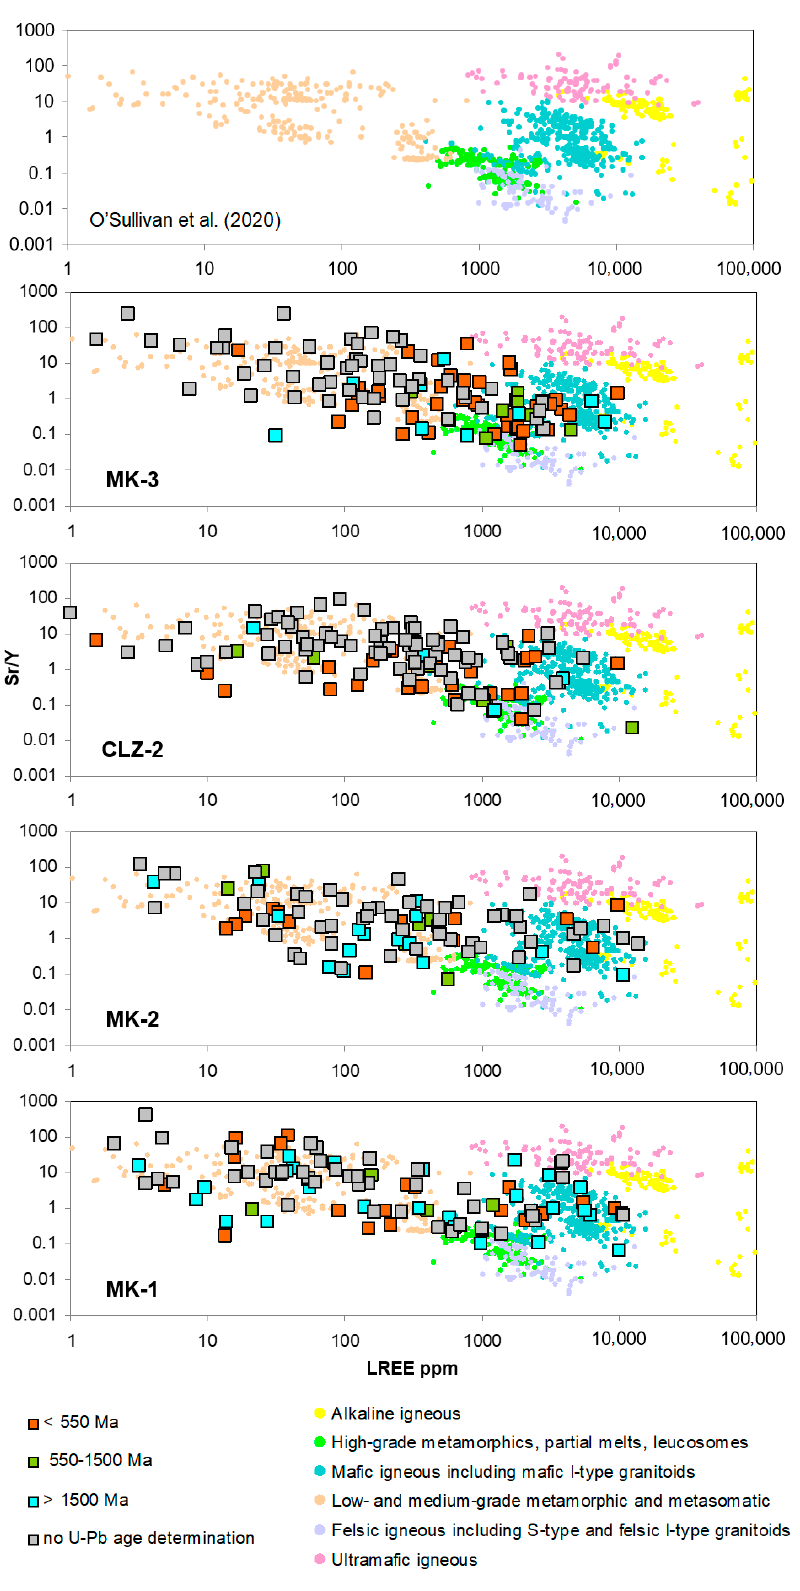
Figure 5. Apatite trace element data from samples MK-1, MK-2, MK-3 and CLZ-2 shown on Sr/Y— light rare earth element (LREE; La + Ce + Pr + Nd) diagrams. Data are coded to show the main age groups and which did not yield useful age data. Detrital compositions are compared with those from apatite parent rocks as compiled by O’Sullivan et al.